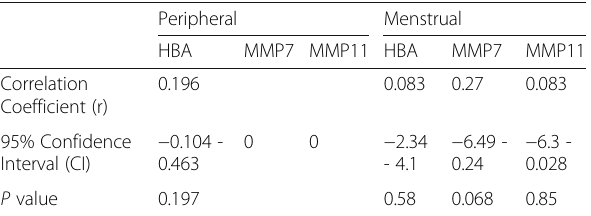
Table 2 Correlation between age of participants and HBA, MMP7 and MMP11 levels